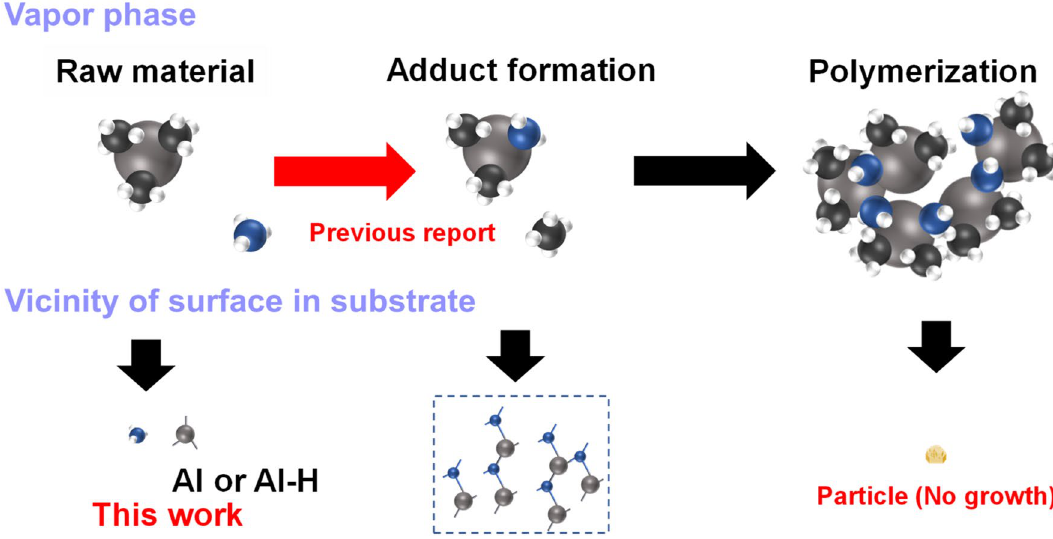
Figure 1. Reaction pathway during raw material transport at AlN growth, and the estimation of final material condition before its deposition on an AlN